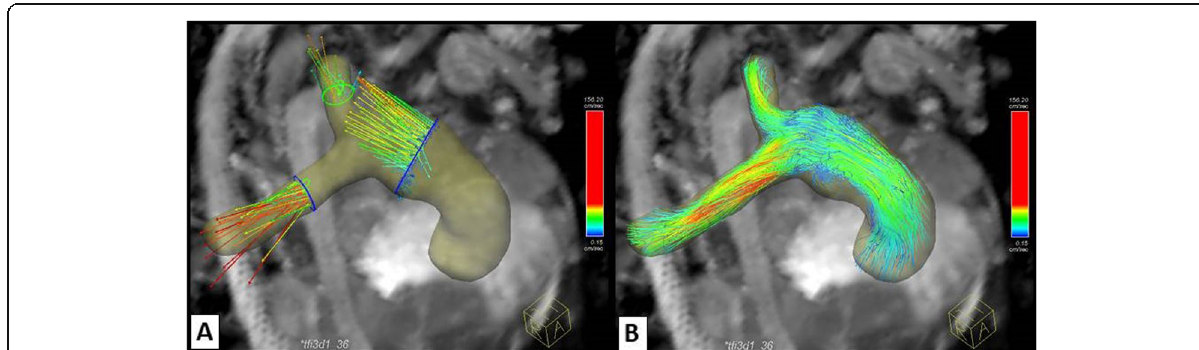
Fig. 3 4D-CMR flow of the MPA, RPA, and LPA of a surgically repaired TOF patient with RV-PA conduit. a Vector field maps showing the velocity and direction of blood flow across pulmonary arteries during systole (arrows). This type of visualization provides a quick overview of velocity fields. b Streamlines color map showing also the forward flow across pulmonary arteries during systole. This type of visualization is useful to visualize 3D velocity fields at discrete time points. A high-systolic velocity across the RPA is noted by the two methods (red color map). CMR: cardiac magnetic resonance, MPA: main pulmonary artery, RPA: right pulmonary artery, LPA: left pulmonary artery, TOF: tetralogy of Fallot